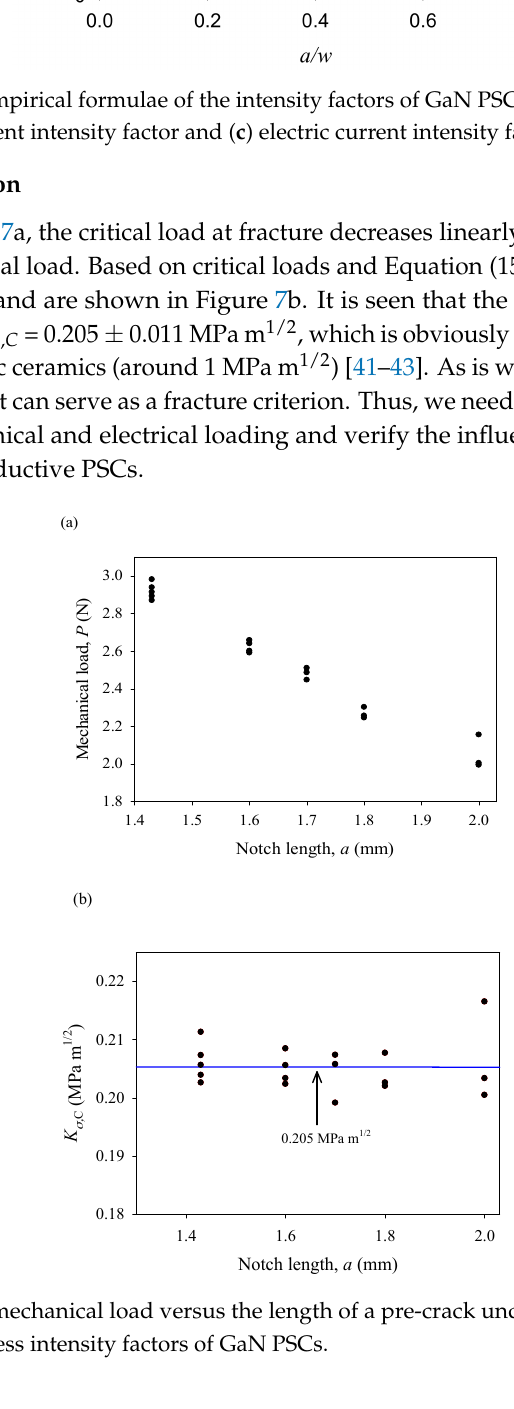
Table 2. Fitting coefficients ( e j in Equation (16)) under the different types of intensity factors. Intensity Factors